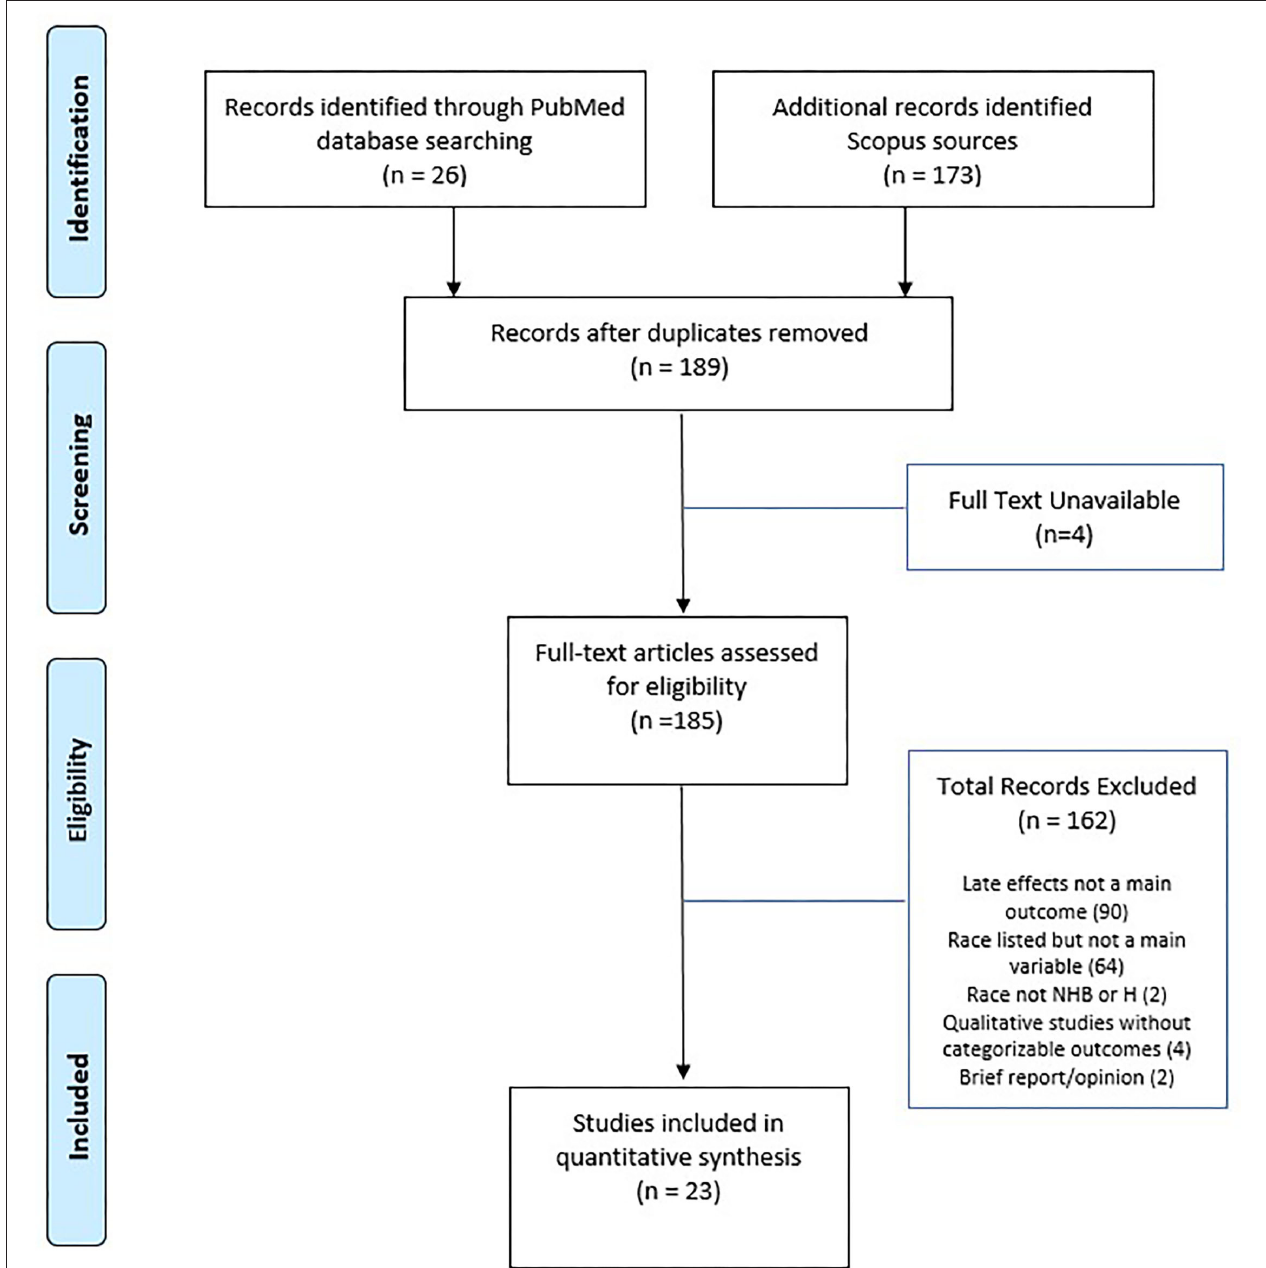
FIGURE 1 | PRISMA diagram of study selection. Adapted from